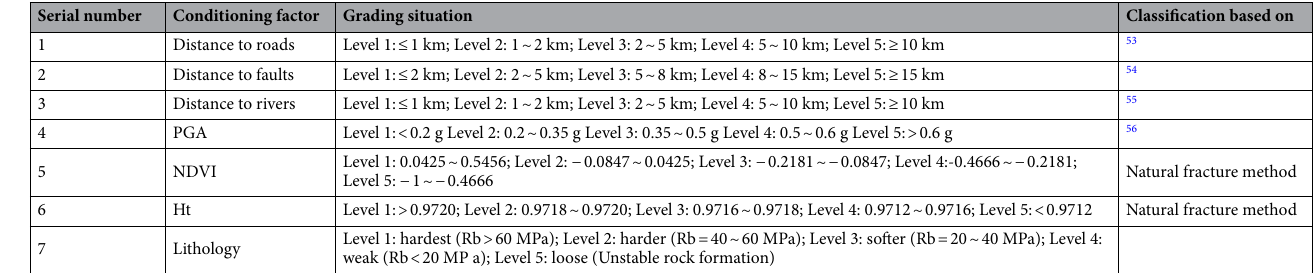
Table 3. Classification of Influential